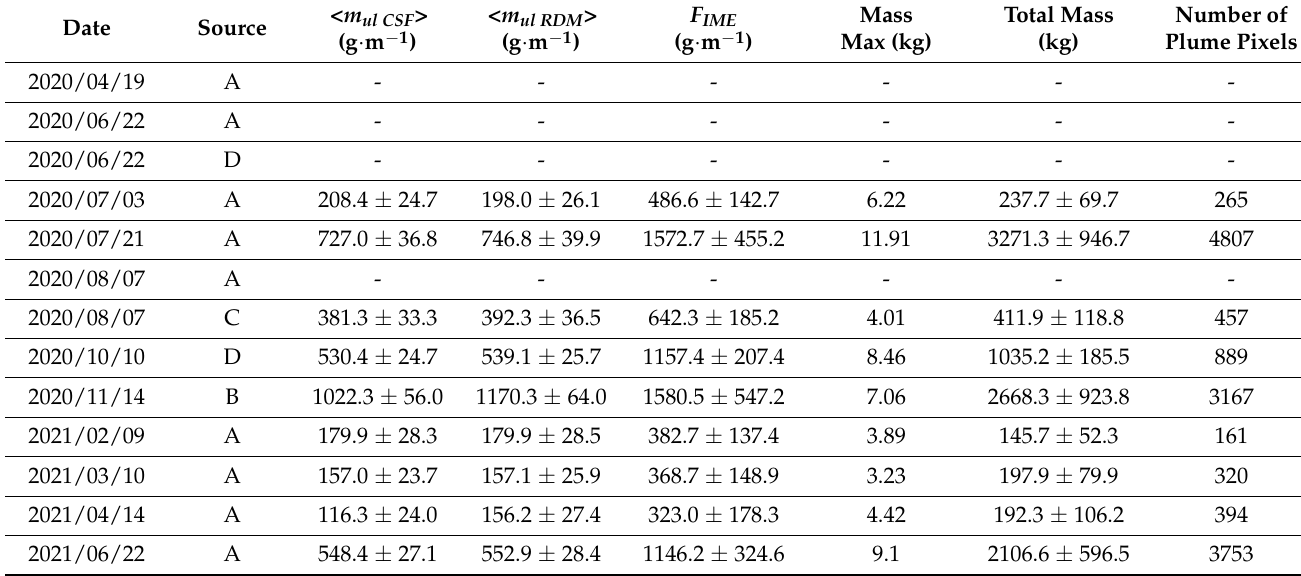
Table A2. Estimation of the wind normalized source flow rate in cases where the full mask is used. The dashes represent cases without “full” masks due to plume